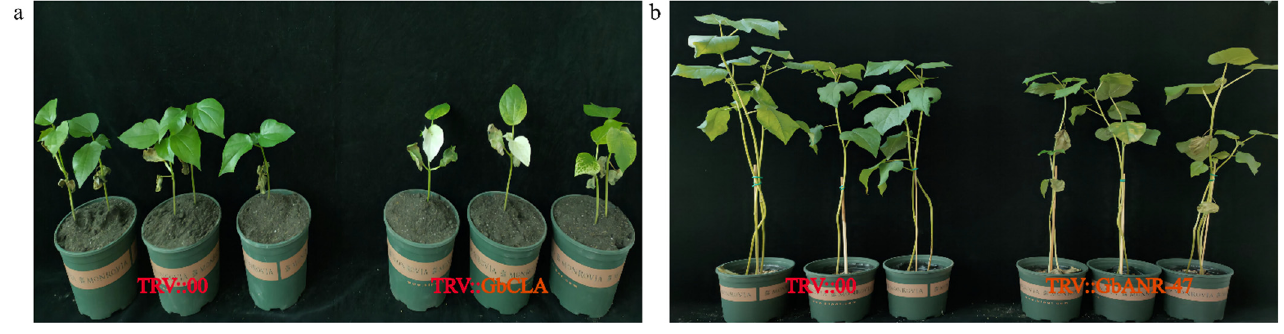
Figure 8. Effects of silencing Gb_ANR-47 on 06-146 susceptibility to FOV. Two weeks after infiltra- tion, seedlings were inoculated with FOV. ( a ) Ten-day-old cotton plants were infiltrated with Agro- bacterium carrying TRV:: GbCLA . Images were taken at 2 weeks after infiltration; ( b ) representative seedlings of control and silenced plants after inoculation with FOV at 21 days post-inoculation (dpi); ( c ) qRT–PCR results of silencing efficiency; ( d ) responses of control (TRV::00) and silenced (TRV:: Gb_ANR-47 ) plants to FOV at 21 dpi. DSI of control and silenced plants, each involving 15 experimental replicates. The DSI was measured at 21 dpi. The error bars represent the standard deviations of 15 biological replicates; the asterisks indicate statistically significant differences, as determined by t tests (** p < 0.01). 3. Discussion The ANR gene family plays important roles in plant growth and development and stress resistance [13,21–23]. However, few studies have been conducted on the ANR gene family in plants. One ANR protein have been found in Arabidopsis thaliana , and six ANR proteins have been found in rice; however, there are fewer reports on ANR proteins in other species. Along with the development of sequencing technology, through genome- wide analysis, it has become possible to identify the origin, diversity, and biological func- tions of gene families [24]. Studies on ANR family genes in cotton are rare. This study was the first to reveal that there are more ANR family genes in cotton than in rice and Ara- bidopsis thaliana , which may be the result of the doubling of the genome in cotton. Accord- ing to gene number differences, phylogenetics, and chromosomal locations of the ANR gene family members in cotton, the ANR gene family has been conserved throughout the long-term evolution of cotton. Although A01 has the longest chromosome length, it con- tains only two ANR genes, which indicates that there is no correlation between the distri- bution of ANR genes in G. barbadense and the chromosome length (Figure 1).